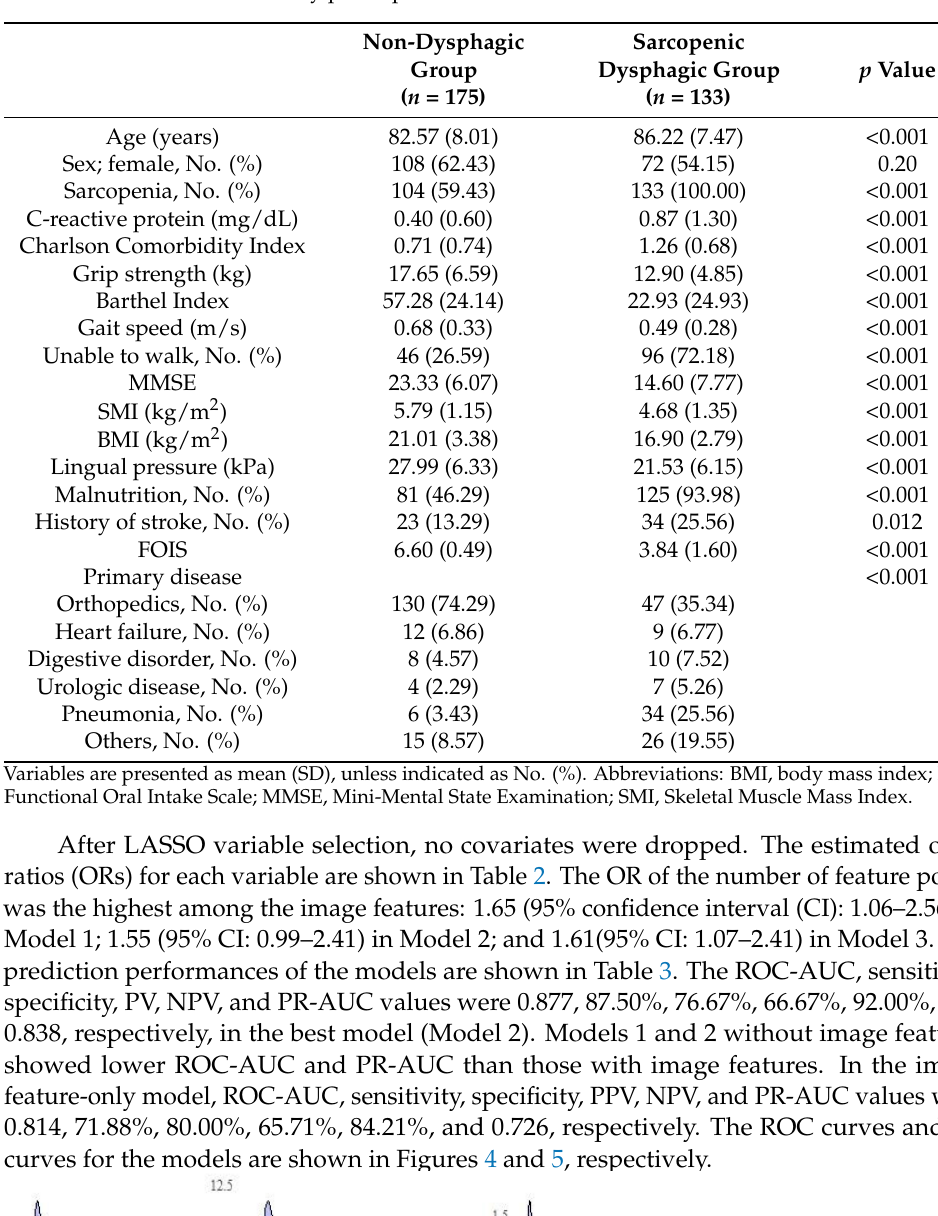
Table 1. Characteristics of study participants.